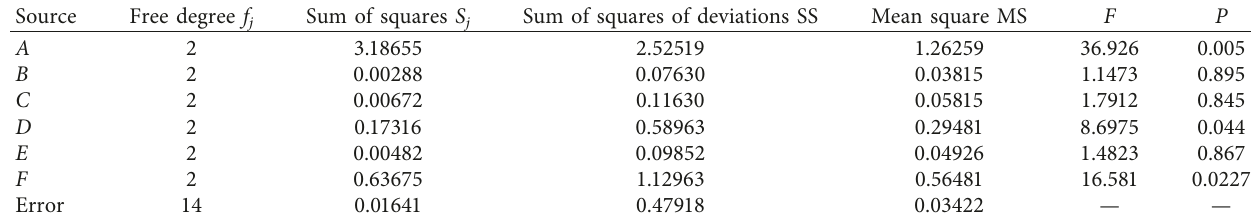
Table 6: Analysis results of quality characteristics of the WC-CoCr cladding layer.